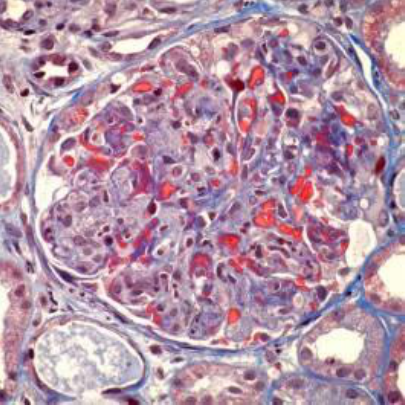
FIGURE 2. Trichrom stain: endocapillary hypercellularity and large subepithelial deposits (red).